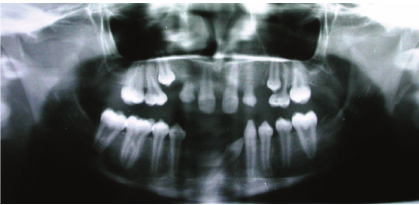
Figure 4: Orthopantomograph showing multiple dental